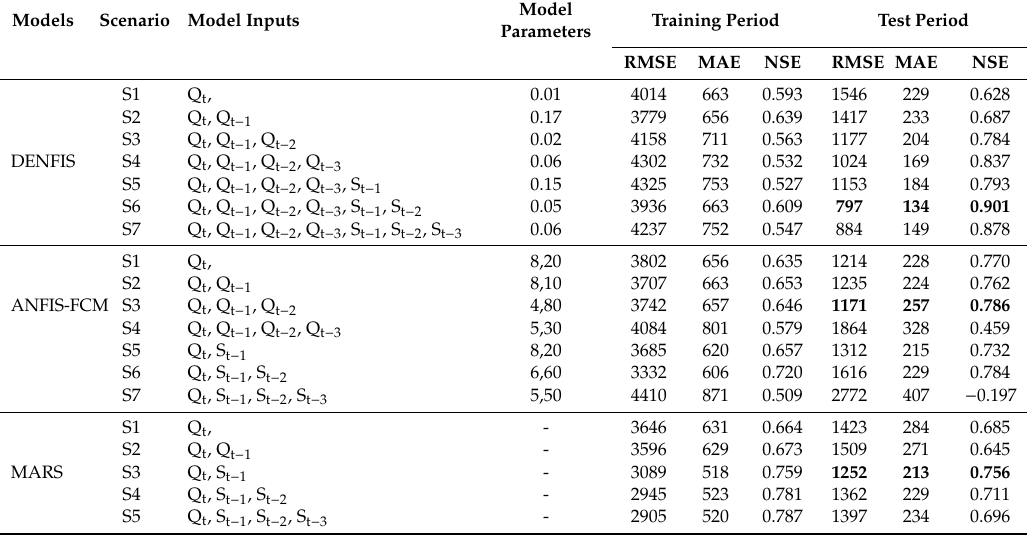
Table 3. The training and test statistics of the DENFIS, ANFIS-FCM and MARS models using di ff erent combinations of sediment and streamflow for daily suspended sediment prediction, Beibei